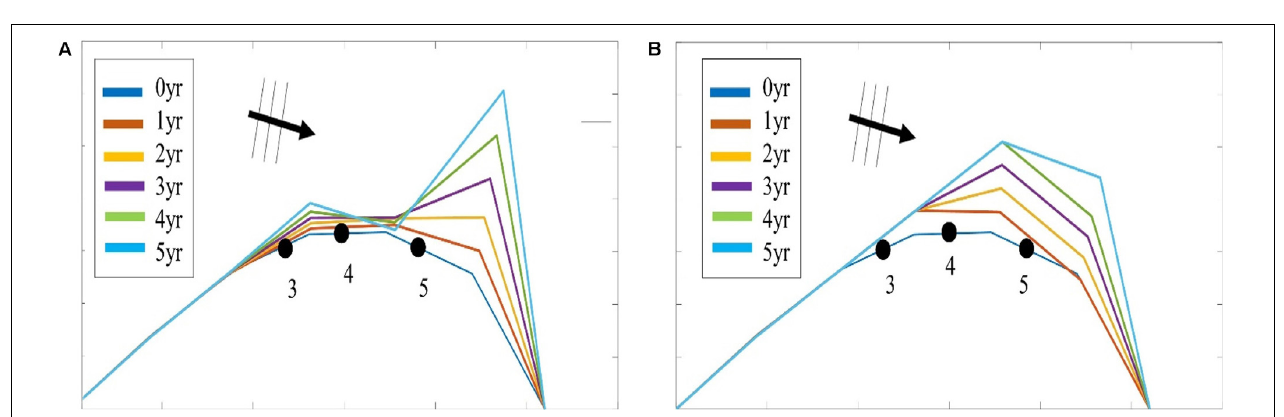
FIGURE 3 | Example of high-angle instability with standard central scheme (A) and upwind scheme (B) .